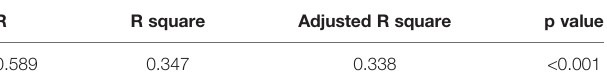
TABLE 5 | Linear regression of validation